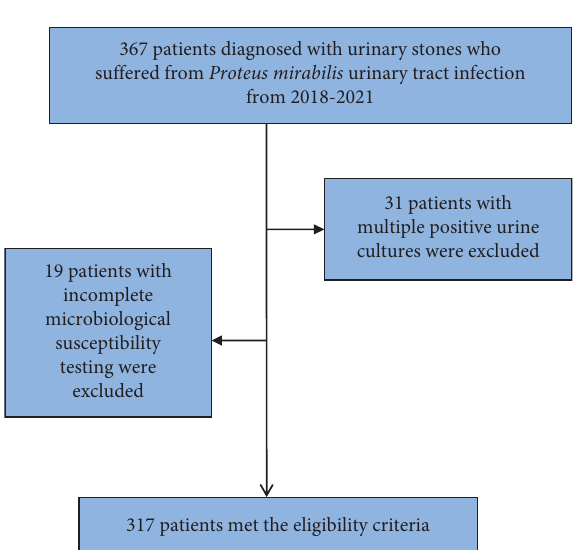
Figure 1: Flowchart for the selection of patients diagnosed with urinary stones who sufered from Proteus mirabilis urinary tract infection in this study.